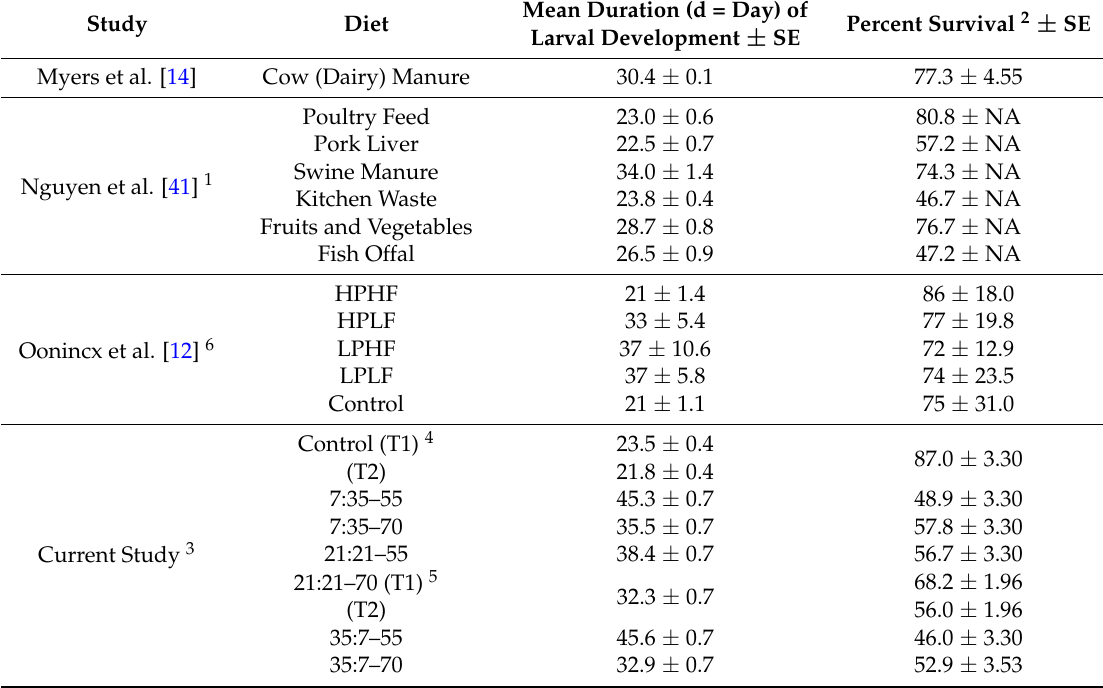
Table 2. Duration of black soldier fly larval development and survival to the prepupal stage when reared on different